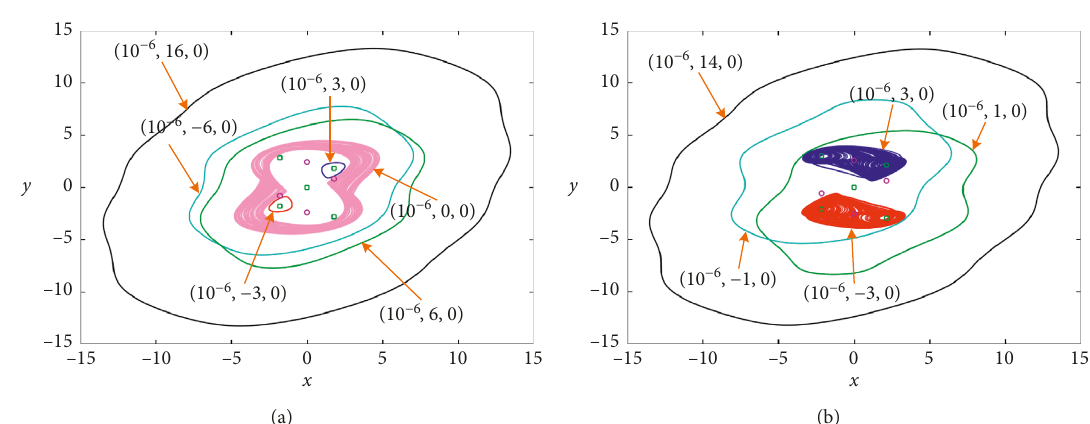
Figure 2: Phase plots of coexisting multiple attractors projected on the x - y plane for different initial values. (a) For k coexisting multiple attractors. (b) For k